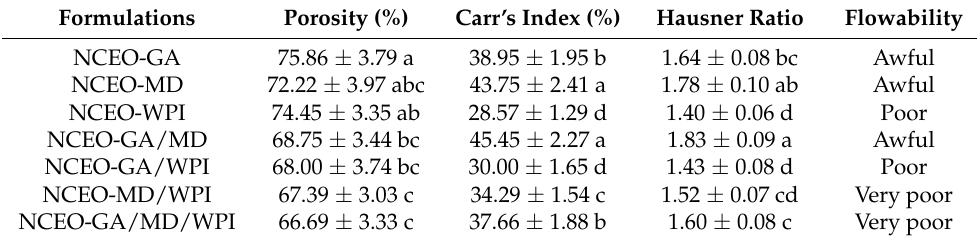
Table 6. Porosity, Carr’s index, Hausner ratio, and flowability of CEO